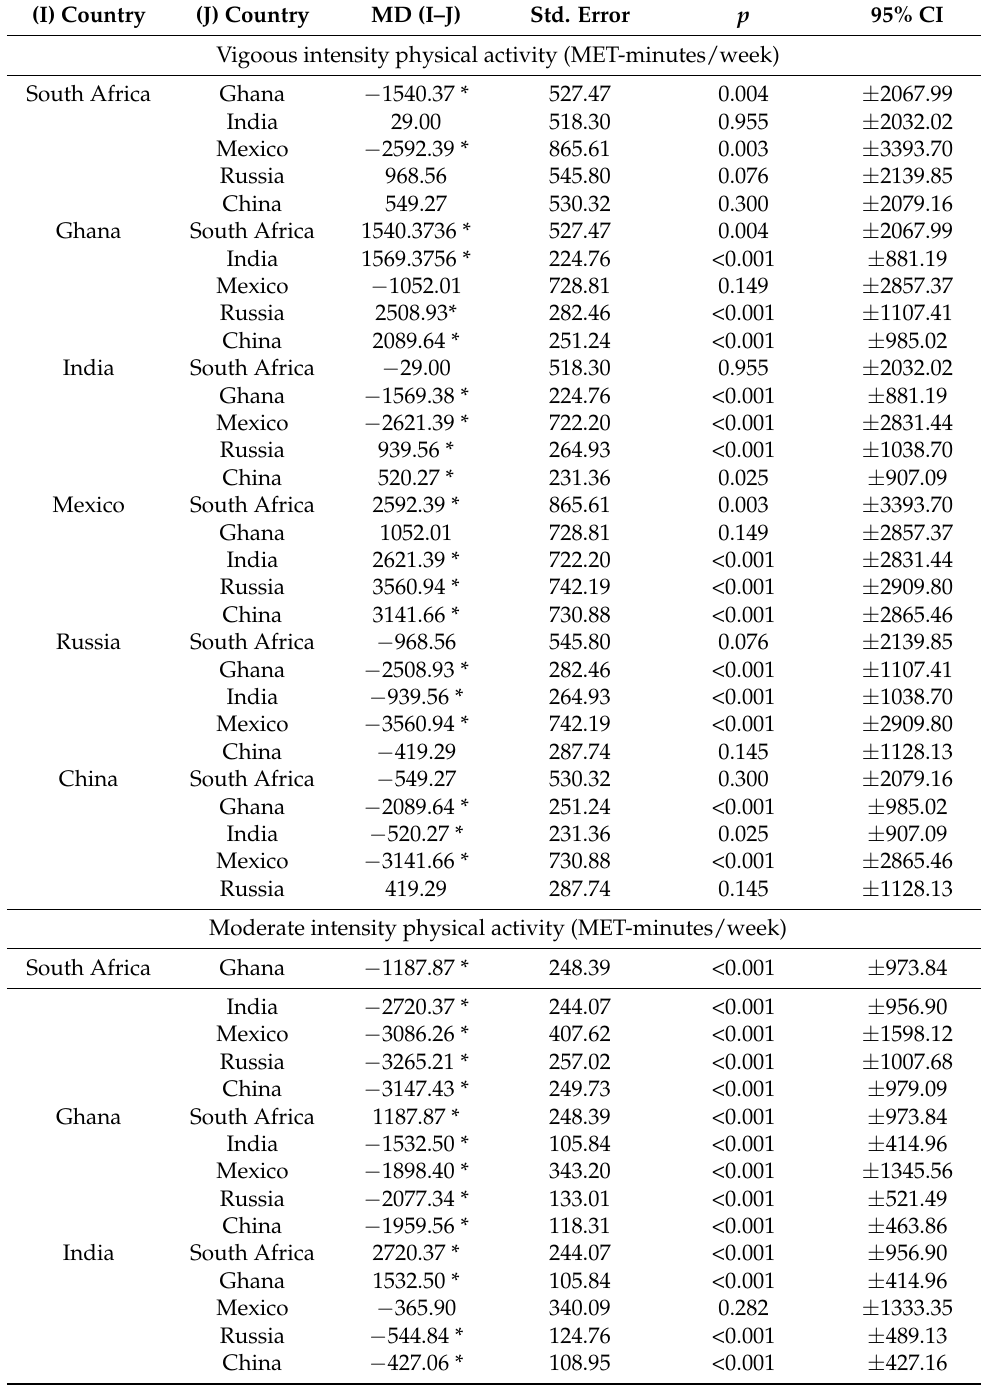
Table 4. Post hoc and multiple comparison test ( n =